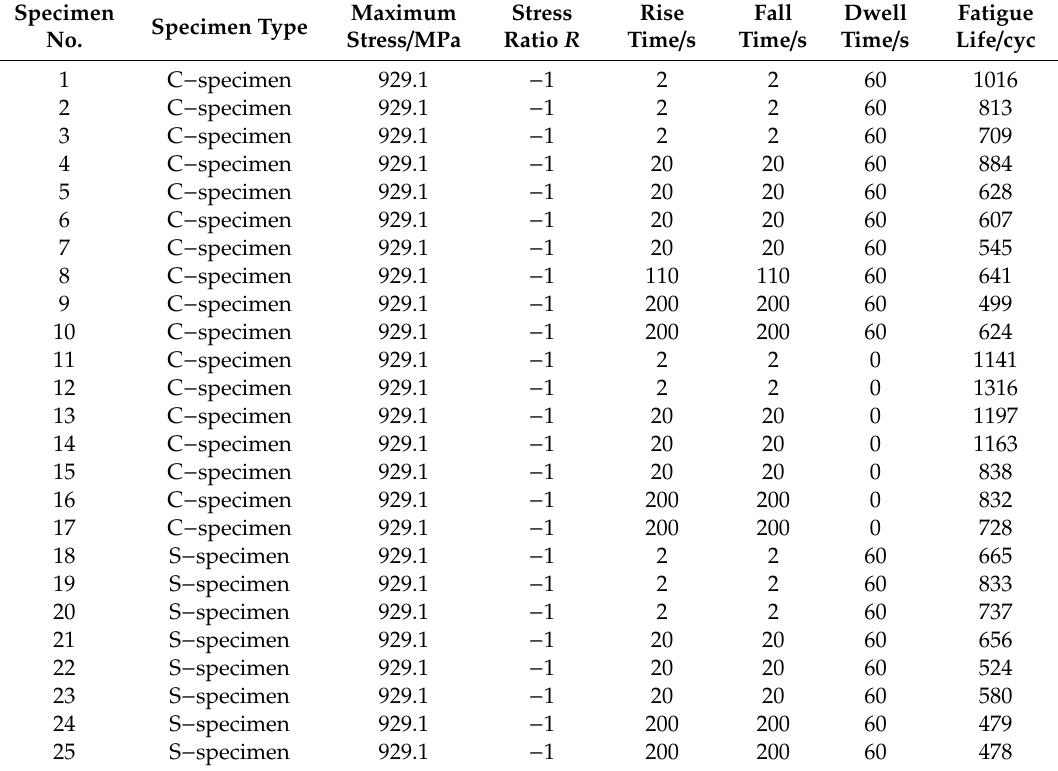
Figure 4. Variation of fatigue life with the rise and fall time for both the conventional fatigue test and the dwell fatigue test, in which the lines denote the linear regression results of the fatigue life with the rise and fall time in log–log scale. Table 1. Loading information and the associated fatigue life of specimens in Figure 4.